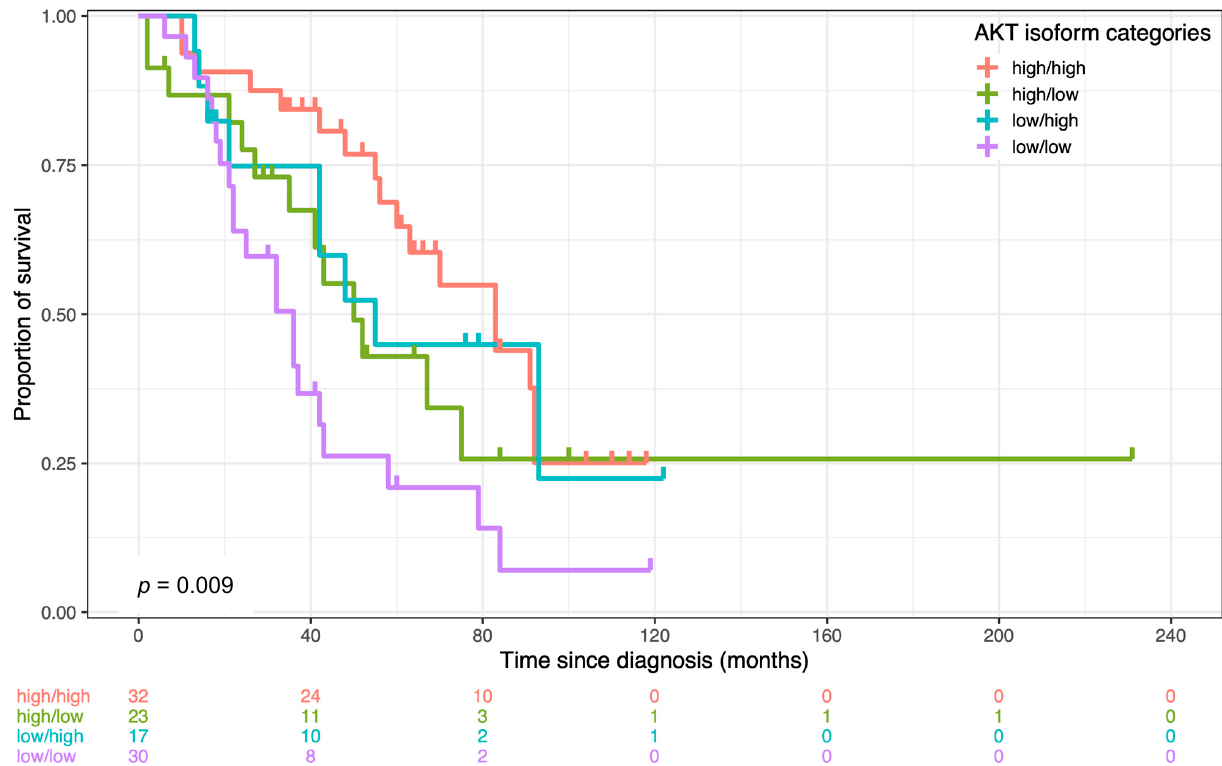
Figure 2. Kaplan–Meier curves representing the overall survival rate by AKT isoform categories. Table 2. Prognostic factors for OS identified by multivariate Cox regression